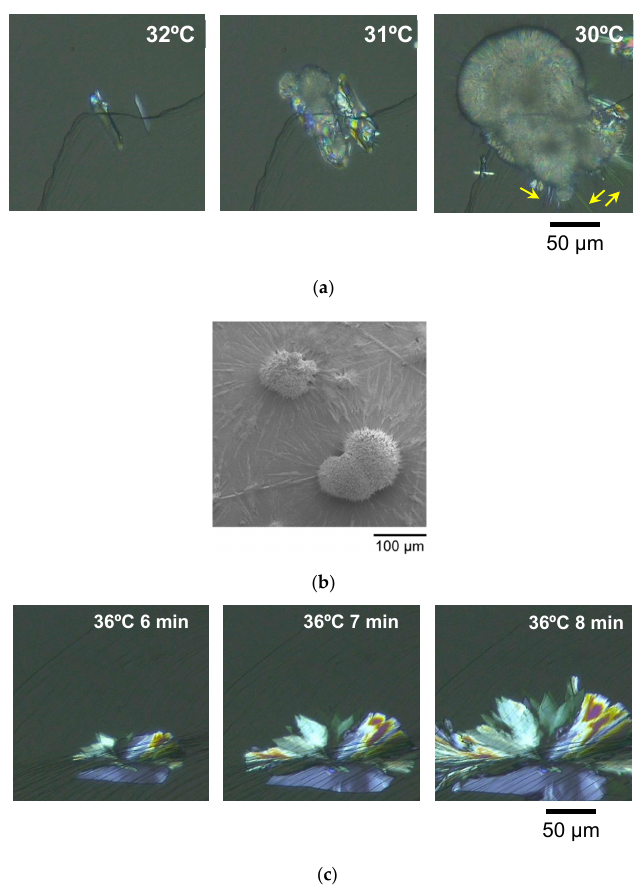
Figure 1. Morphology of LLL crystals growing on highly oriented pyrolytic graphite (HOPG) sheets. ( a ) Polarized optical microscope (POM) images taken in the melt-crystallization process with a constant cooling rate of 1 ◦ C / min, ( b ) a cryo-scanning electron microscope (Cryo-SEM) image taken after the stabilization process, and ( c ) POM images taken in the melt-crystallization process with isothermal cooling at 36 ◦